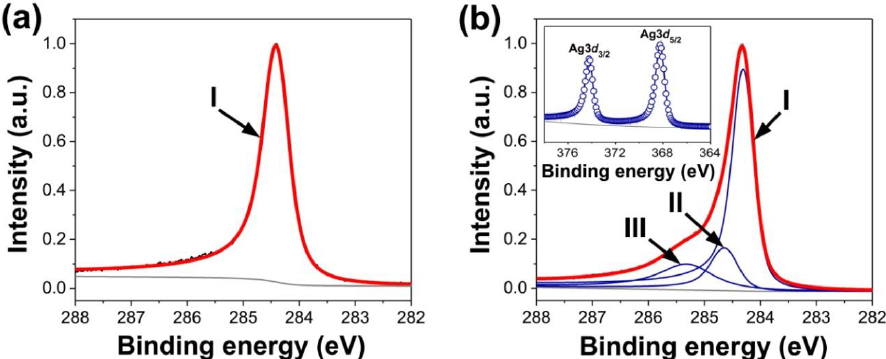
Figure 7. The C 1s XPS spectra of SWCNTs ( a ) and Ag-filled SWCNTs ( b ). The inset in (b) shows the Ag 3d XPS spectrum. Reproduced from M. V. Kharlamova et al. Donor doping of single-walled carbon nanotubes by filling of channels with silver, Journal of Experimental and Theoretical Physics, V. 115, № 3, p. 485-491, 2012, Springer Nature [110].